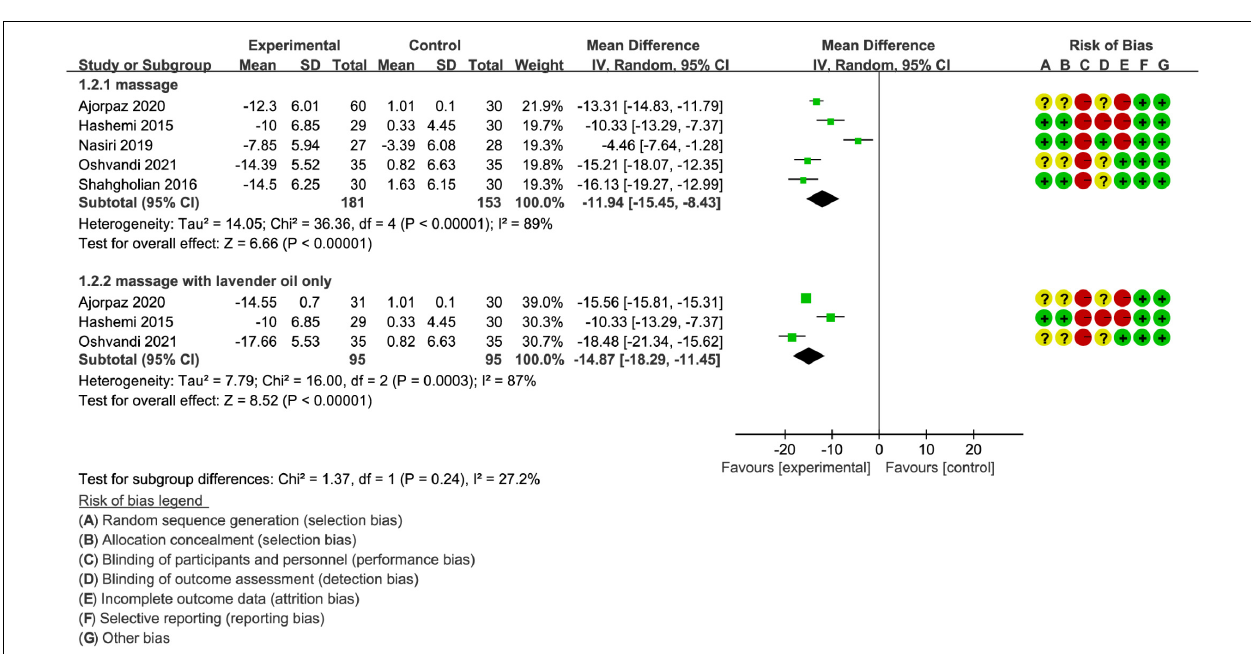
FIGURE 4 | Meta-analysis of mean difference of RLSS at the beginning and end of